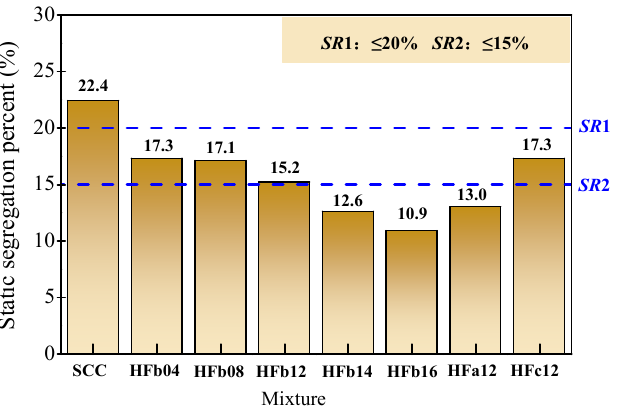
Figure 7. Test results and the corresponding performance level of static segregation resistance.